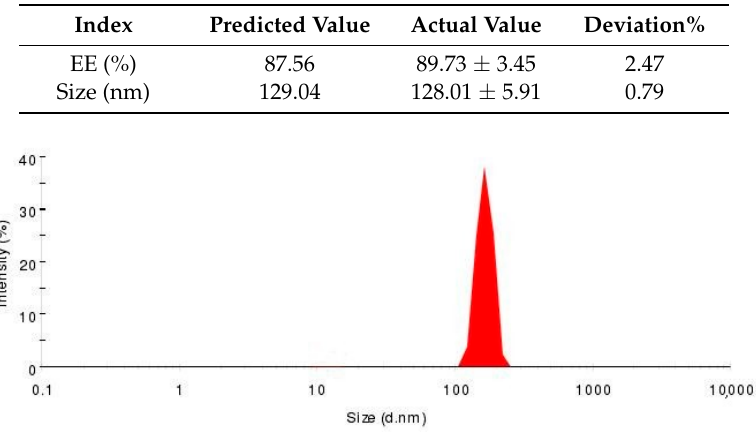
Figure 4. Intensity distribution of GGB-LP.